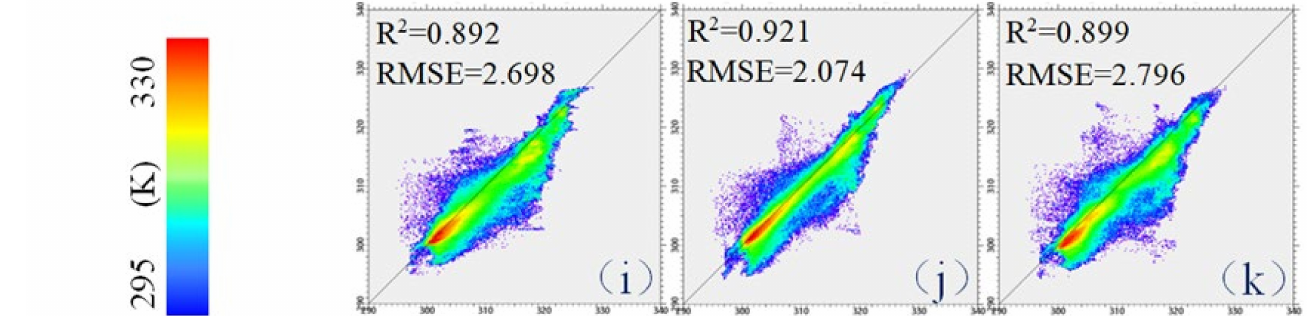
Figure 8. Results of fusing MODIS LST and Landsat 8 LST on 9 August 2014. ( a ): Actual Landsat 8 LST; ( b ): STARFM LST; ( c ): ESTARFM LST; ( d ): FSDAF LST; ( e – h ): the subsets of ( a – d ) corresponding to the blacks quare area in ( a ). ( i – k ): scatter plot between ( a – d ).